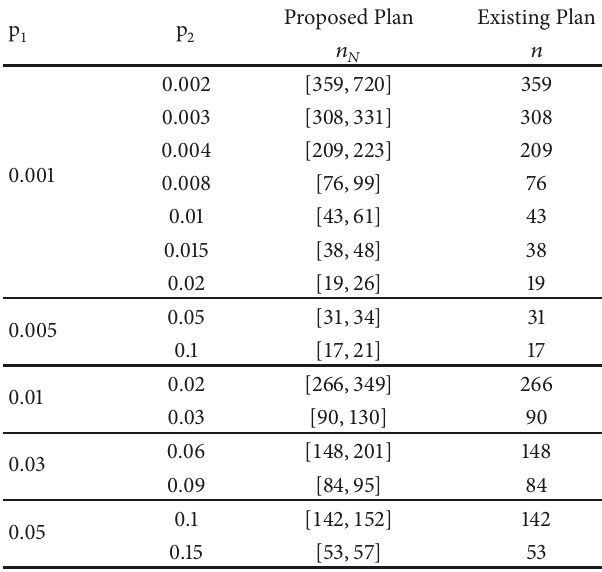
Table 4: The comparison of plans when 𝛼 = 0.05 , 𝛽 =0.10, 𝑟 =2. p 1 p